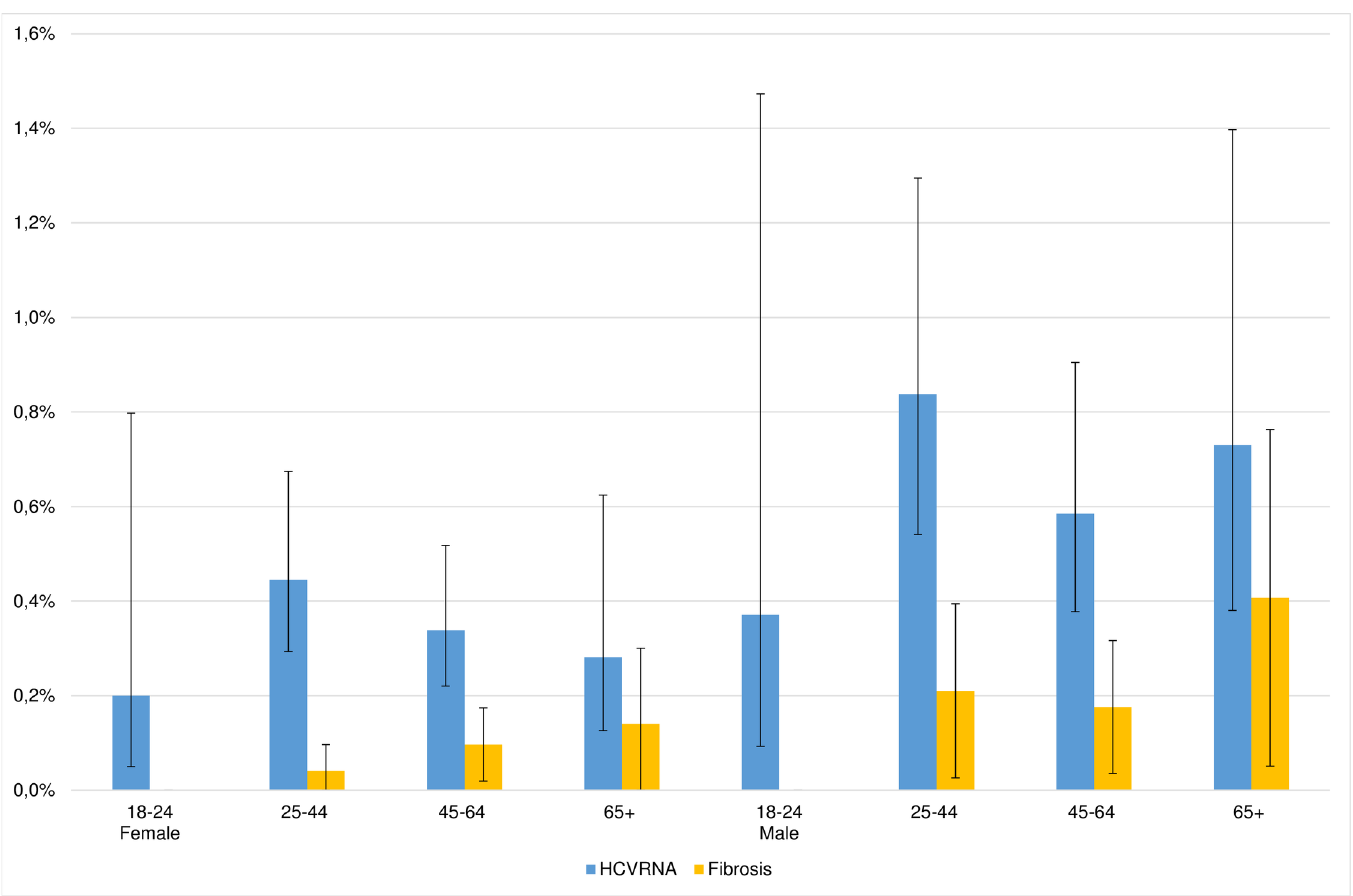
Fig 2. Prevalence of HCV-RNA and prevalenceof significant fibrosis defined by APRI (cid:21) 0.7 and FIB4 (cid:21) 1.45 by sex and age group.